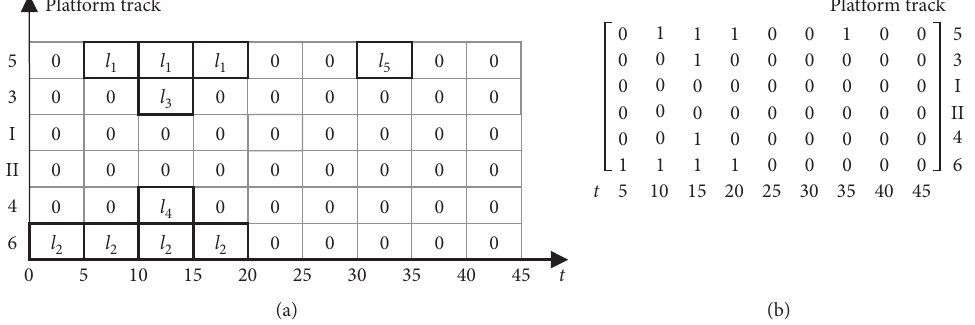
Figure 2: Platform track time-space resource usage plan and time-space resource matrix: (a) usage of platform track time-space resources; (b) platform track time-space resource